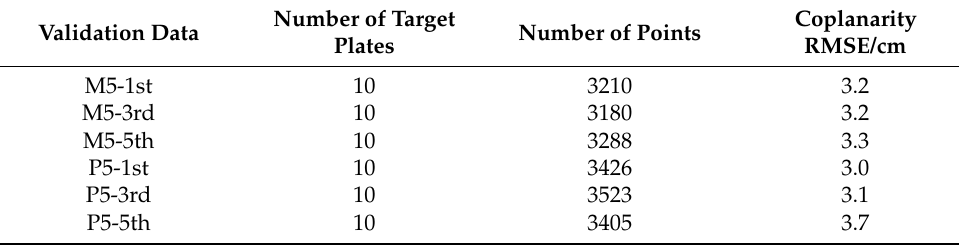
Table 3. Absolute coplanar accuracy after applying Z0-3rd calibration results. Table 4. Accuracy of coplanar fitting by applying the Z0-3rd calibration results. Validation